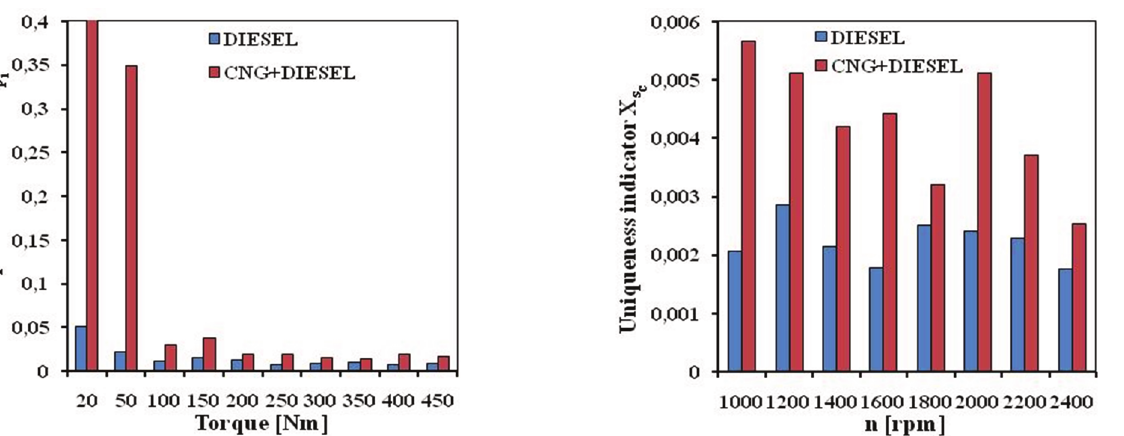
Fig. 11. Comparison of the value of the uniqueness indicator for the mean indicated pressure of the Perkins 1104D-E44TA engine, running according